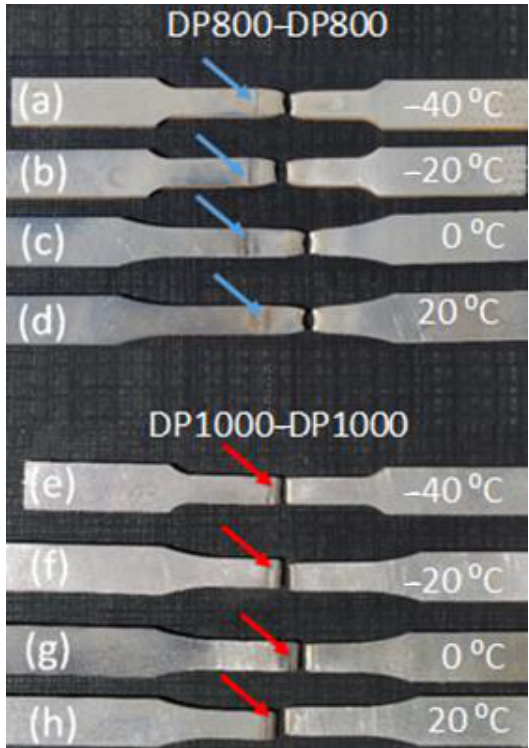
Figure 8. Representative fracture samples of DP800-DP800 ( a – d ) and DP1000-DP1000 ( e – h ) between testing temperatures of − 40 °C and 20 °C.